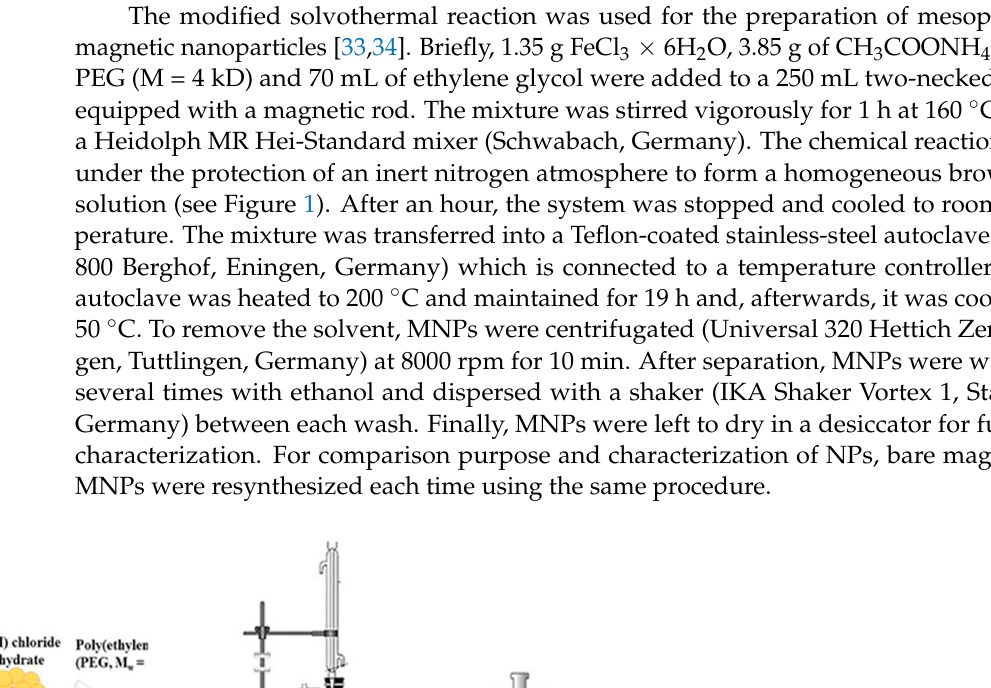
Figure 1. Schematic illustration of mesoporous MNPs preparation using solvothermal method.